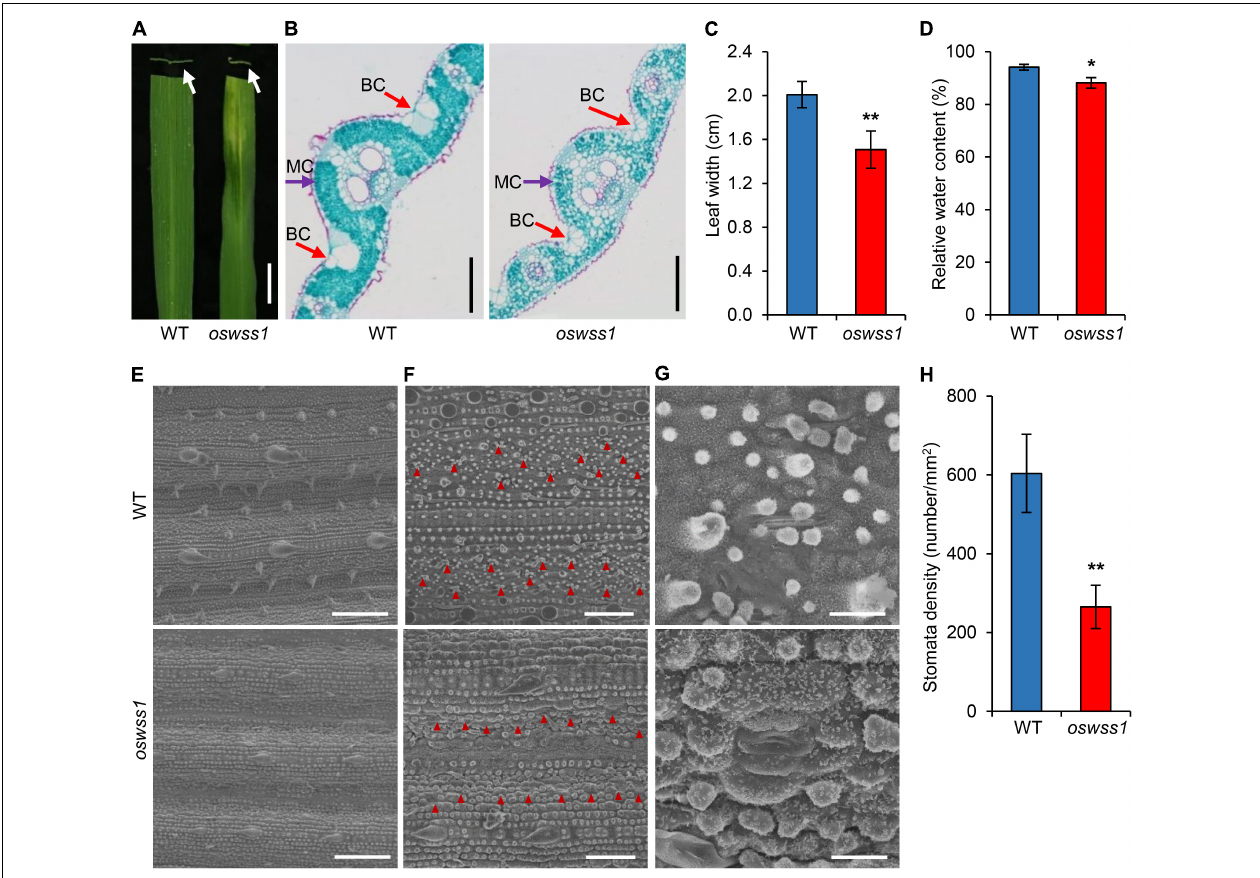
FIGURE 2 | Morphology comparison between wild type (WT) and oswss1 leaves at the tillering stage (87 DAS). (A) Close-up image and cross section of WT and oswss1 mutant leaves. Arrows indicate the cross section of water-soaked spot leaf. Scale bar = 2 cm. (B) Comparison of cell structure between WT and oswss1 leaves. BC, bulliform cell; MC, mesophyll cell. Scale bars = 200 µ m. (C) Comparison of leaf width between WT and oswss1 leaves. (D) Comparison of relative water content between WT and oswss1 leaves. (E) Scanning electron microscopy analysis of leaf morphological characteristics between WT and oswss1 leaves. Scale bars = 100 µ m. (F) Comparison of stomata density between WT and oswss1 leaves. The red triangles indicate the positions of stomata. Scale bars = 50 µ m. (G) Morphological characteristics of stomata between WT and oswss1 leaves. Scale bars = 10 µ m. (H) Statistical analysis of stomata density between WT and oswss1 . Values are mean ± SD ( n = 6). * P < 0.05; ** P < 0.01 (Student’s t